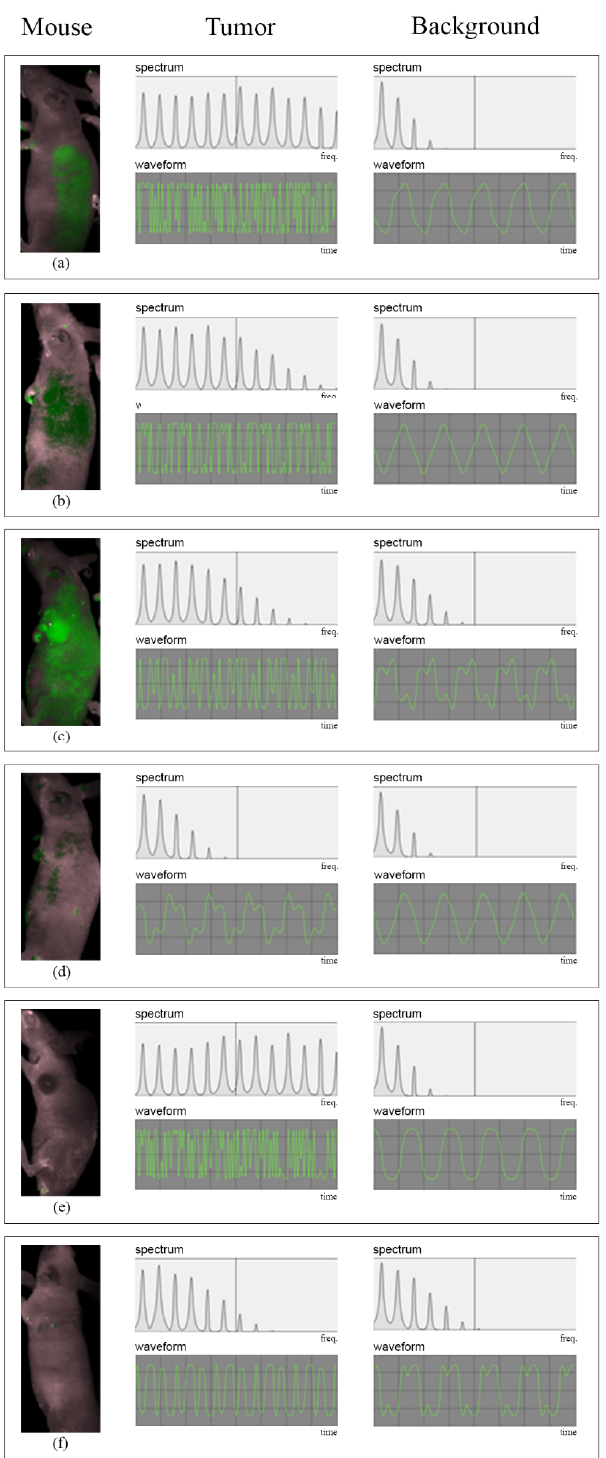
Figure 4. Spectrum and waveforms of the sonified results from each mouse in the experiment. The left column shows the processed NIRF images from the fluorescence imaging system on grayscale photographs of each mouse ( a – f ), showing variable fluorescence signals from the tumor. The middle column shows the result of auditory display from the tumor area, with the spectrum ( above ) and waveform ( below ) from the tumor. The right column shows the spectrum and waveform of the sound from the background (non-tumor) area. Compared with the background, sounds from the tumor areas of all mice featured a heterogeneous spectrum and irregular